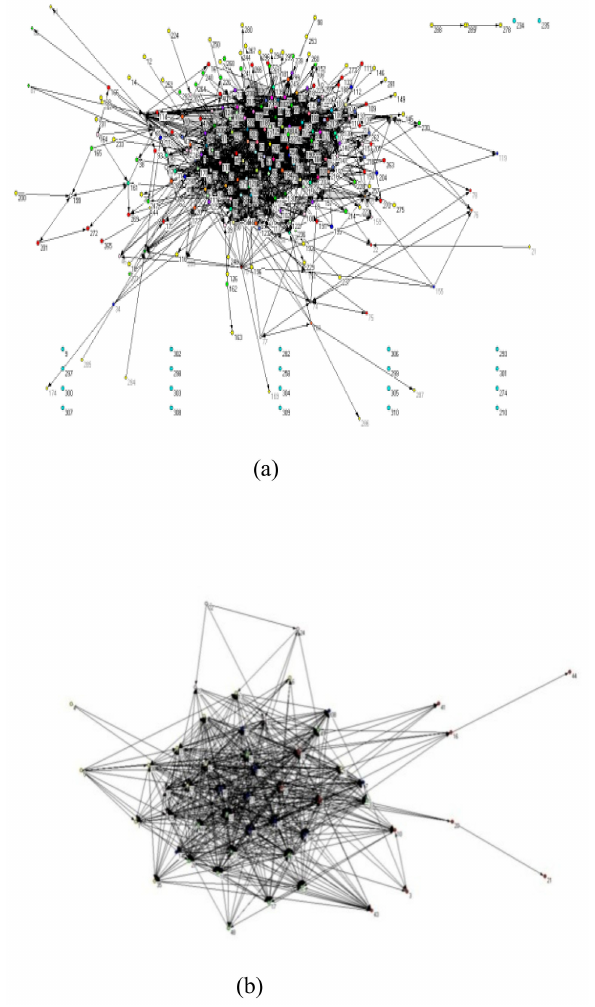
Figure 3. Features of Network Structure of Social Media: ( a ) the Forwarding Network for Hot Blogs on Tianjin Explosion; ( b ) the Forwarding Network for Hot Blogs on Typhoon